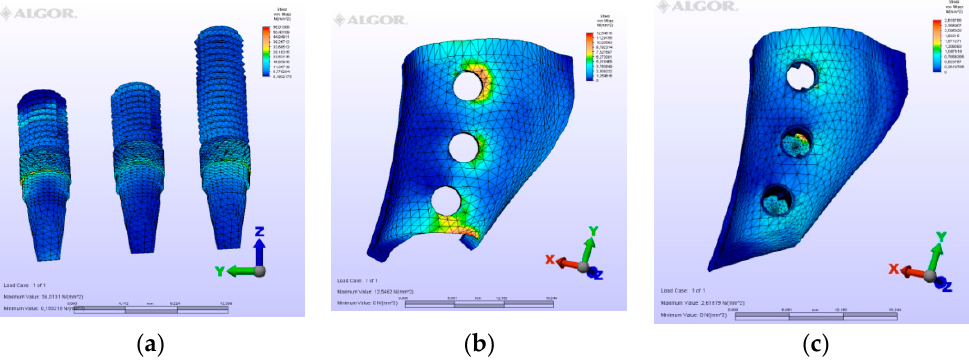
Figure 7. Model M2, horizontal loading. ( a ) the maximum von Mises stresses around implants; ( b ) maximum principle stress in cortical bone; ( c ) maximum principle stress in cancellous bone.